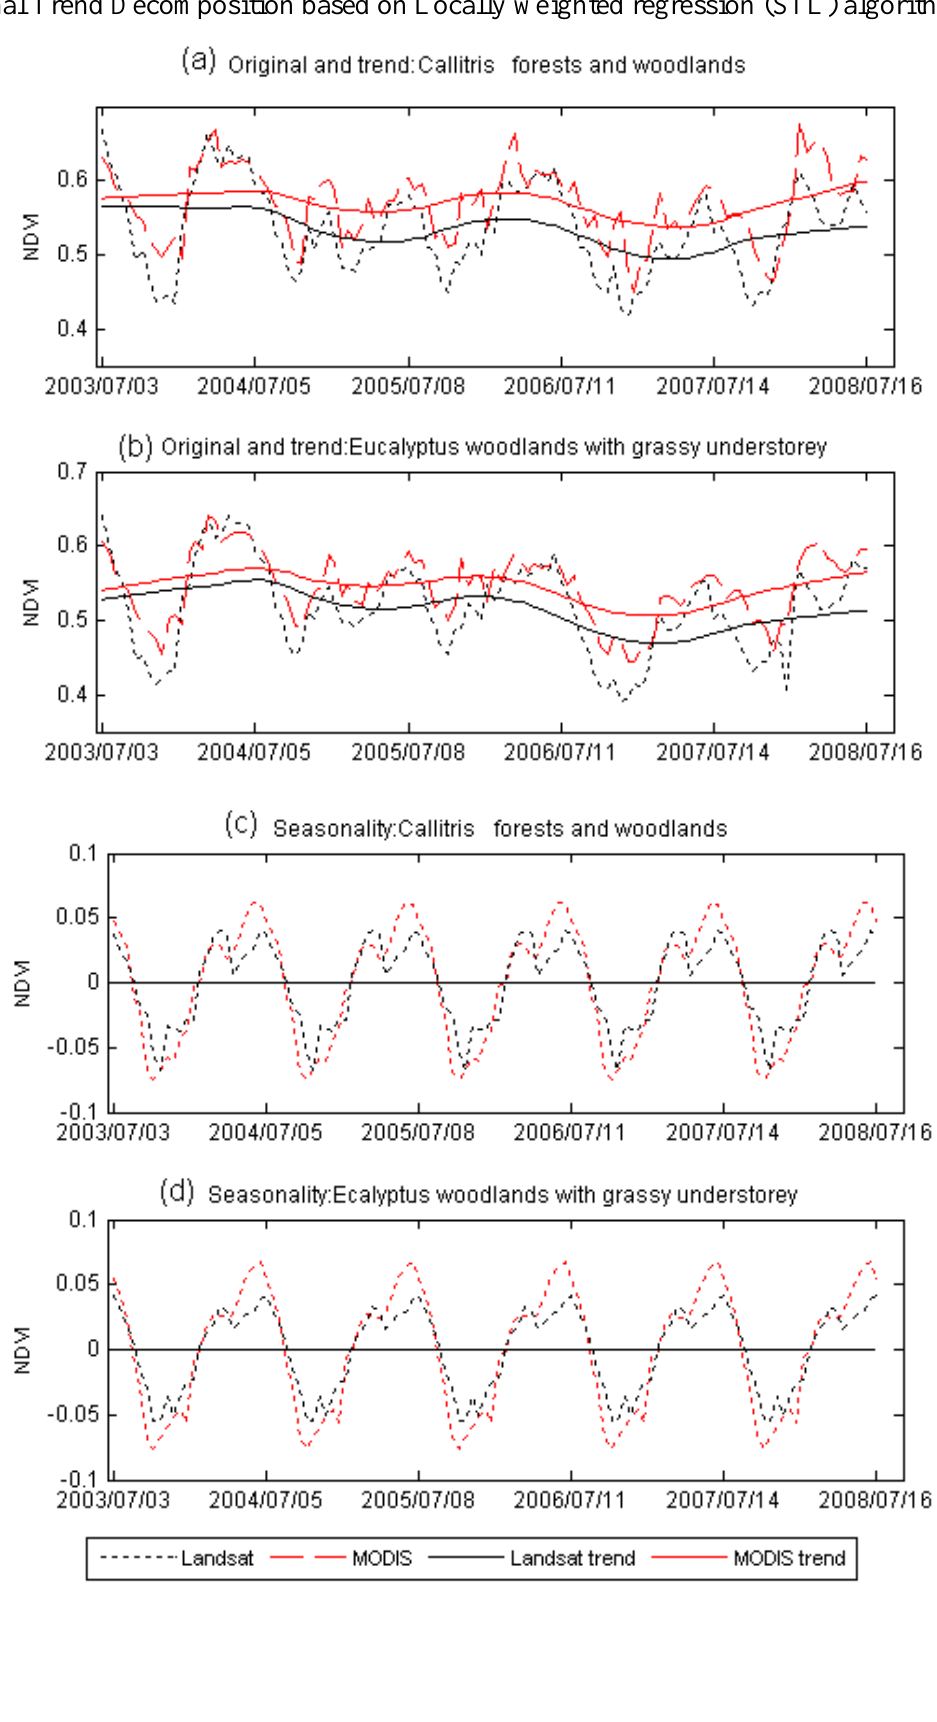
Figure 9. Comparison of LITS generated normalized difference vegetation index (NDVI) time series with Moderate Resolution Imaging Spectroradiometer (MODIS) NDVI time series. The time series were generated averaging all pixels within the vegetation communities. The trend ( a ), ( b ) and seasonality ( c ), ( d ) shown were decoupled using the Seasonal Trend Decomposition based on Locally weighted regression (STL)